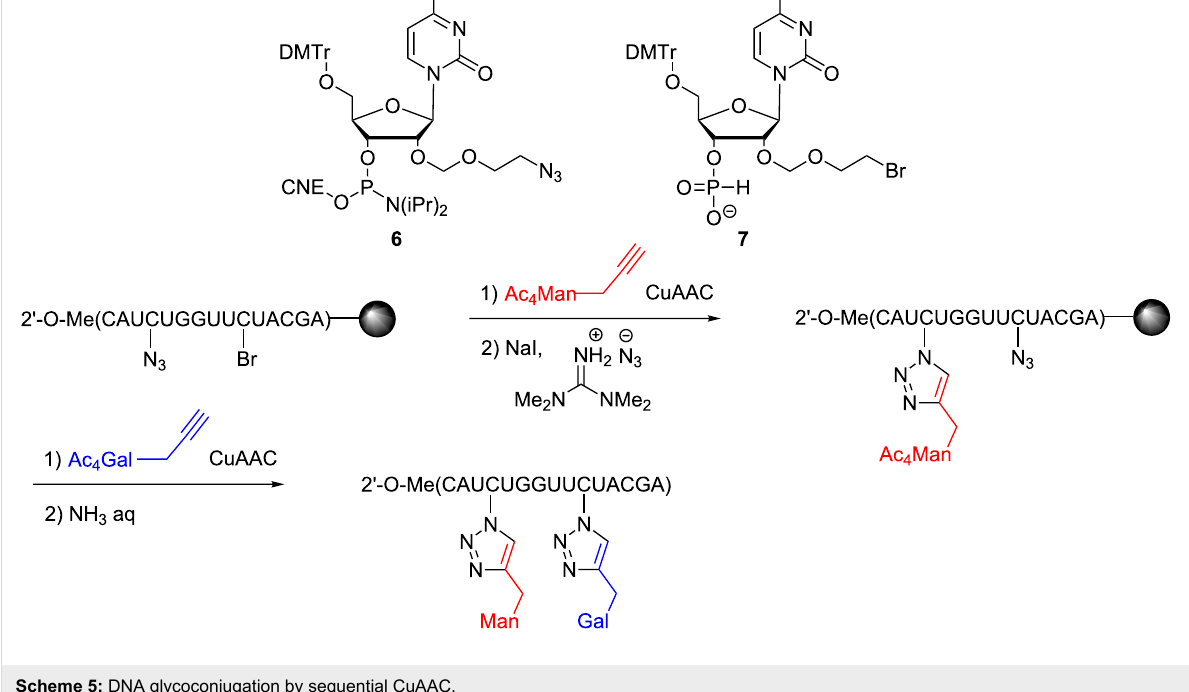
Scheme 5: DNA glycoconjugation by sequential CuAAC.